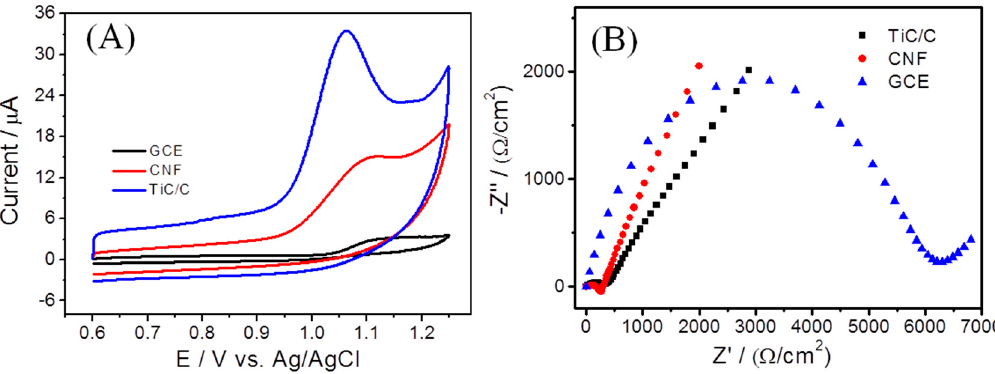
Figure 3. ( A ) CV curves of bare GC, CNFs, and TiC/C-modified electrodes in 0.1 M PBS (pH = 4.0) containing 50 μ M PMT; ( B ) Nyquist plots of bare GC, CNFs, and TiC/C-modified electrodes.